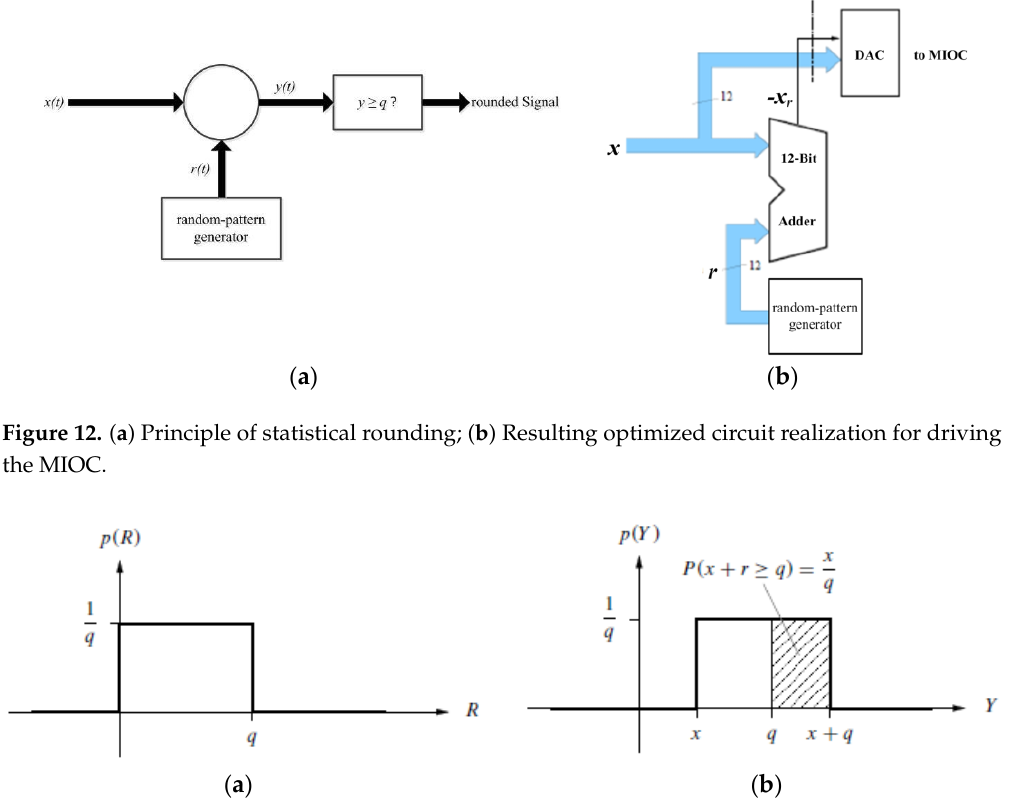
Figure 13. ( a ) Probability distribution function of the random variable R (random numbers r ); ( b ) Resulting distribution function of random variable Y (random numbers y = x + r ).